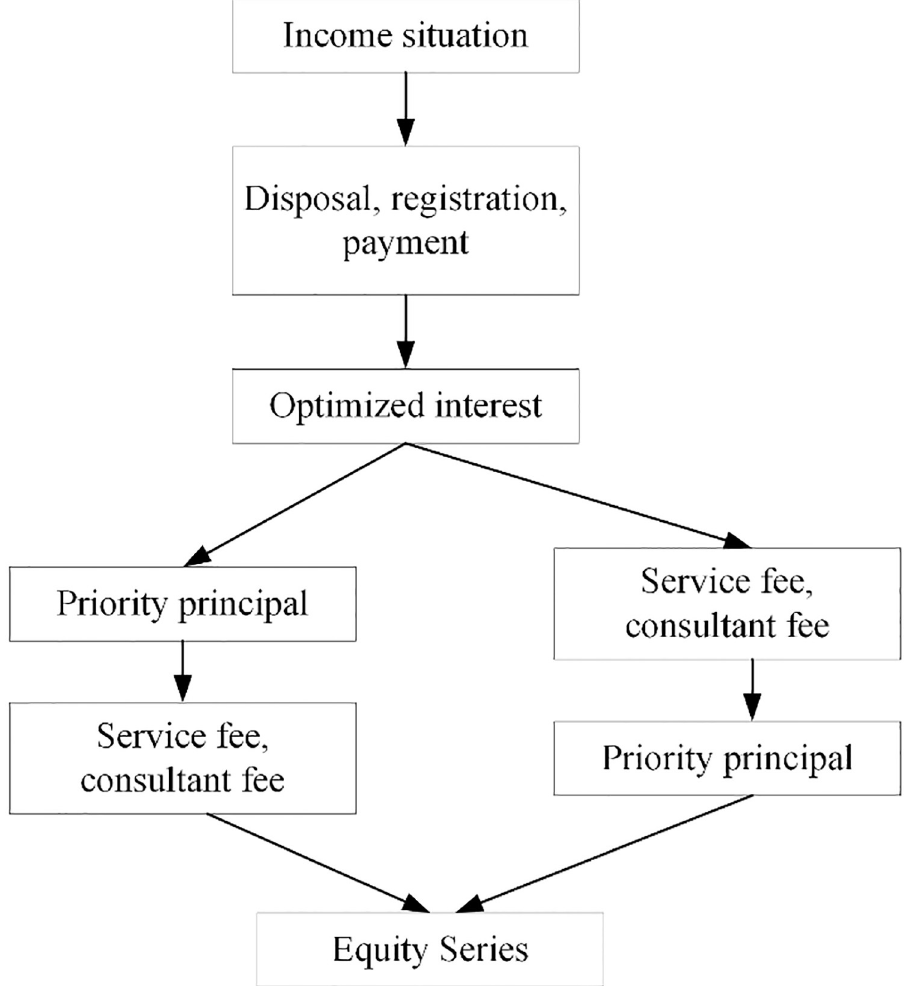
Fig 1. Structural optimization of financial